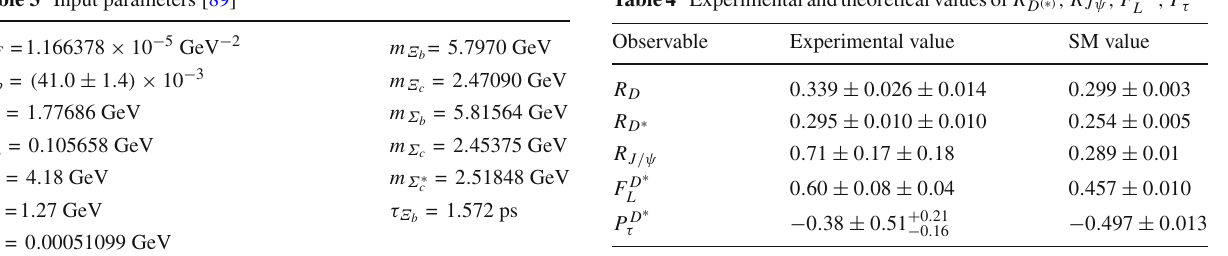
Table 3 Input parameters [89] Table4 Experimentalandtheoreticalvaluesof R D ( ∗ ) , R J ψ , F D ∗